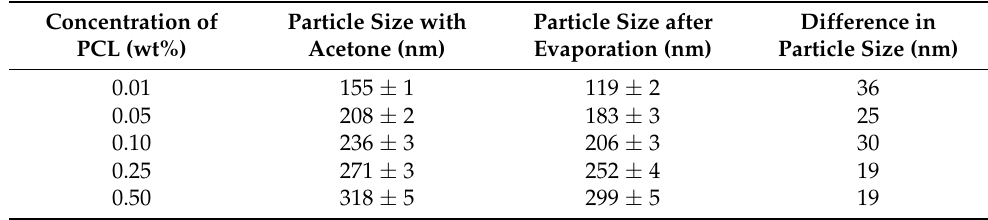
Table 3. Difference in particle sizes before and after evaporation of